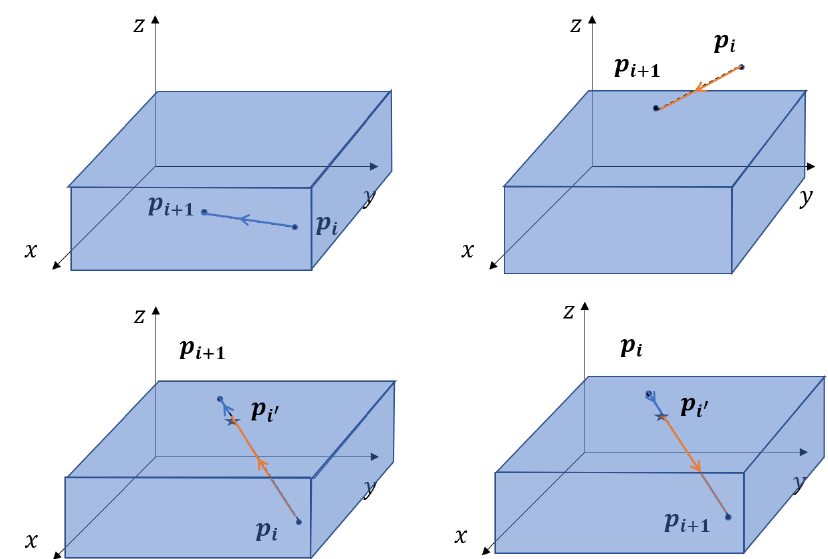
Figure 4. Four types of trip according to the HAUV’s mission mode. A blue arrow illustrates an underwater path, and an orange one means an aerial one. Regarding when the trip crosses domains, the intersection point on surface will be inserted into the target spots